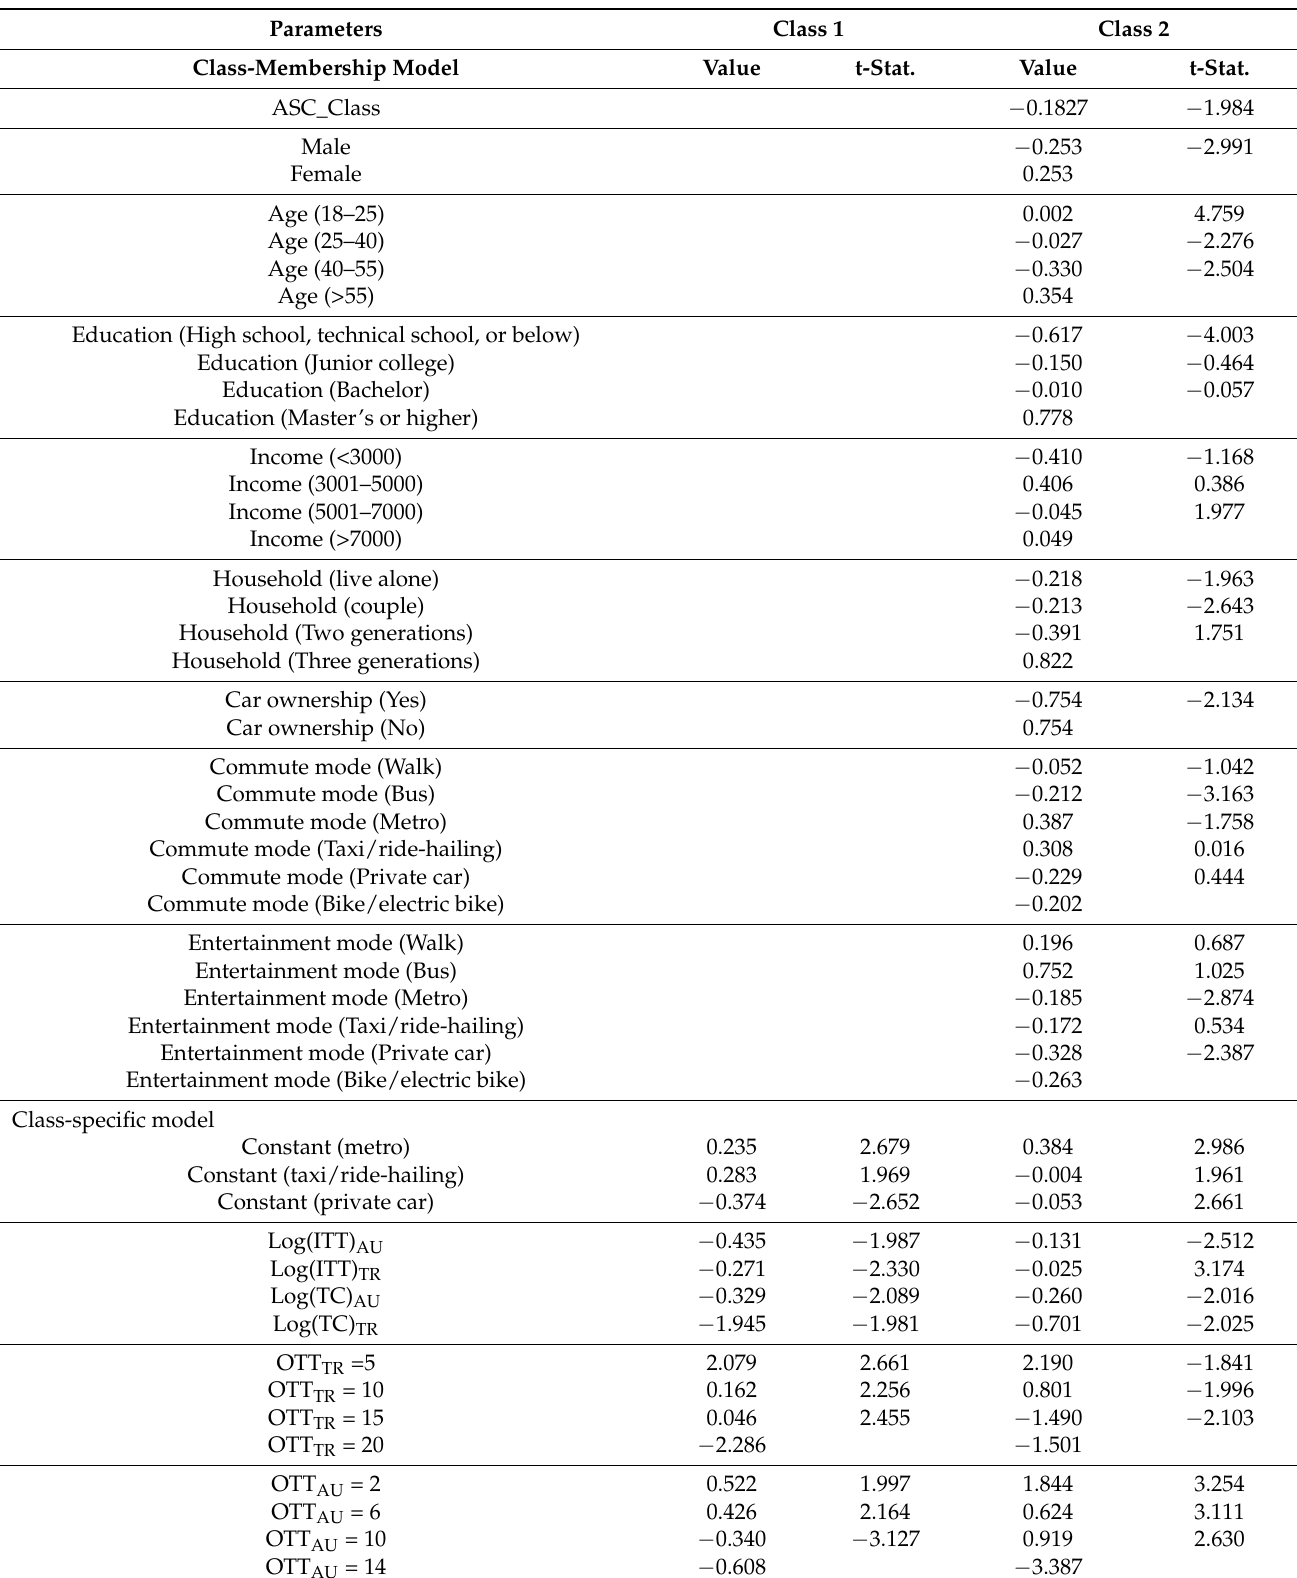
Table 5. Estimation results of the latent class analysis in Wave